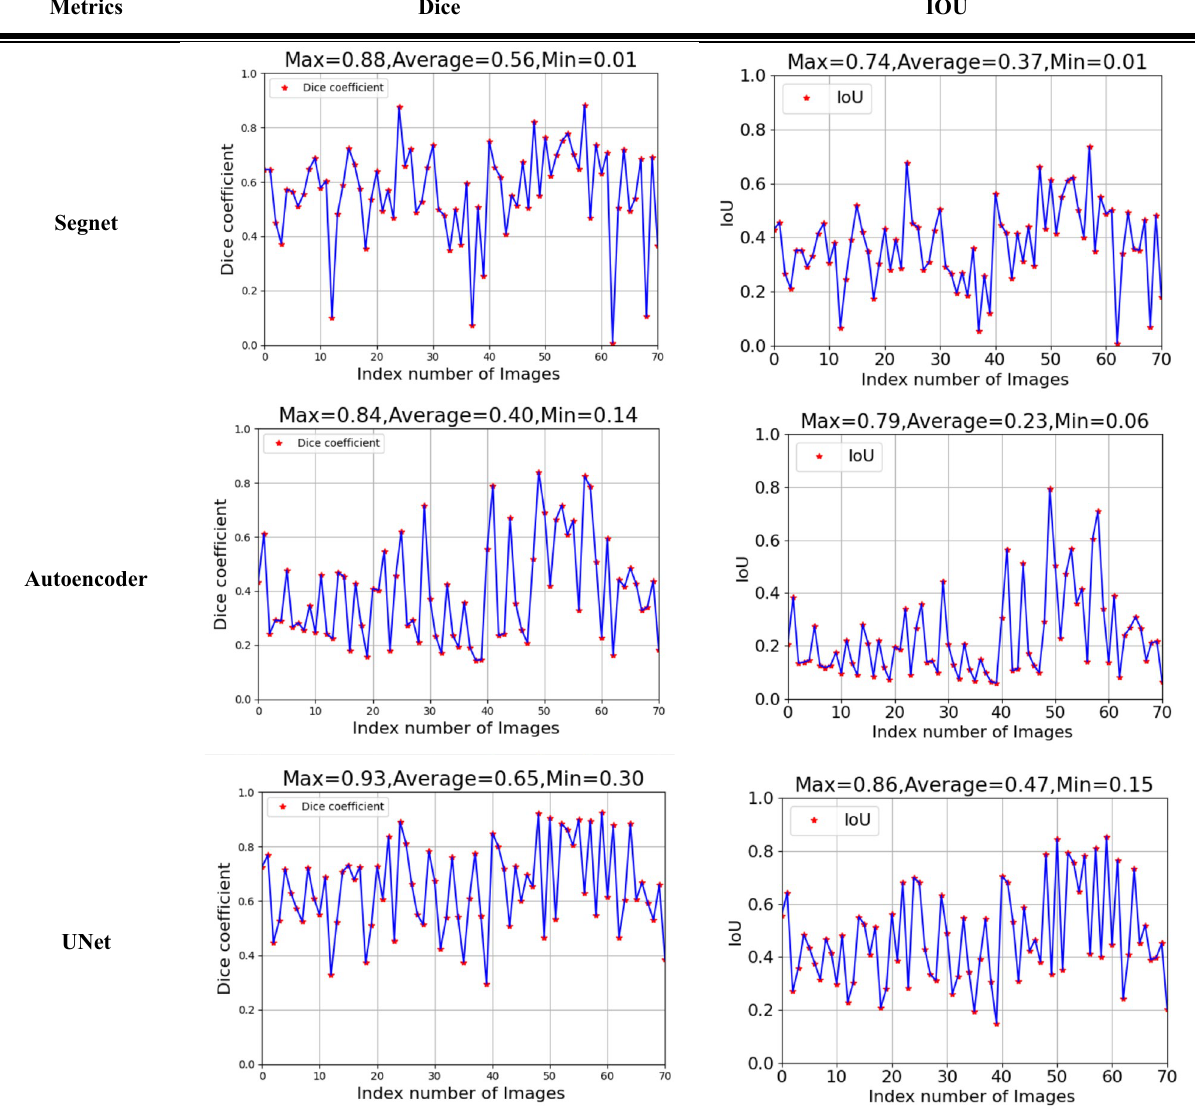
Table 4. The evaluation of Segnet, Autoencoder, and U-Net models.